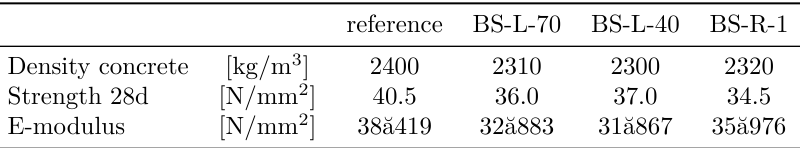
Table 4. Properties of hardened concrete